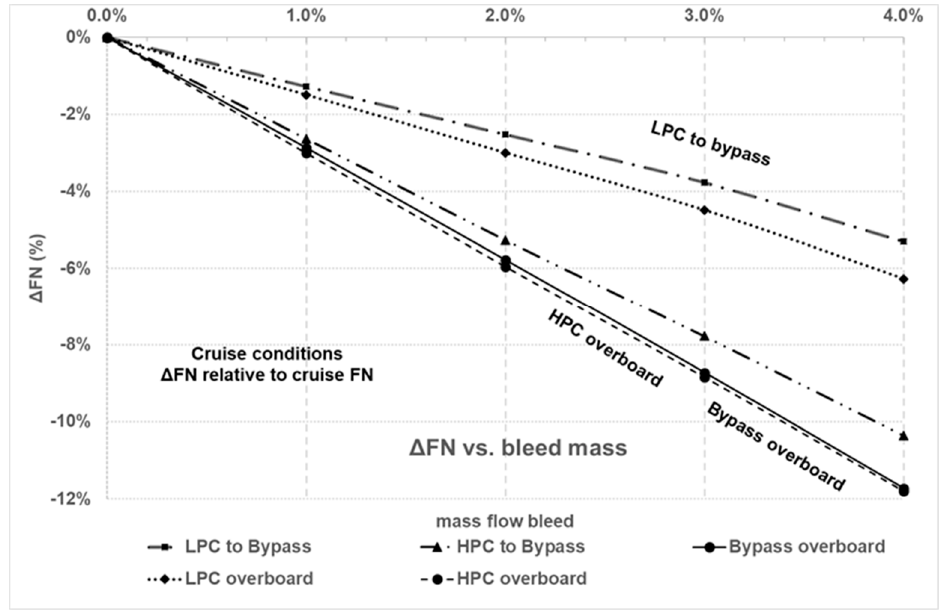
Figure 17. FN change vs. bleed mass.